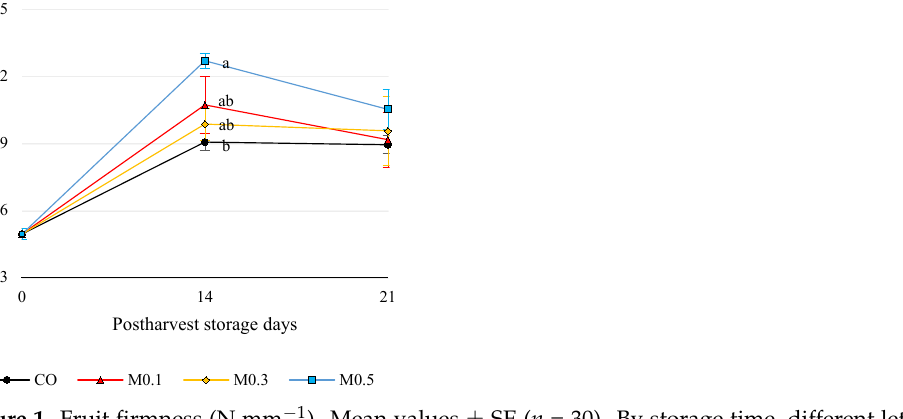
Table 1. Mean values ± SE of skin and fl esh colour, total soluble solids (TSS), and titratable acidity (TA) of ‘Samba’ cherries in relation to storage time and treatments. L* Skin a*/b* Skin L* Flesh